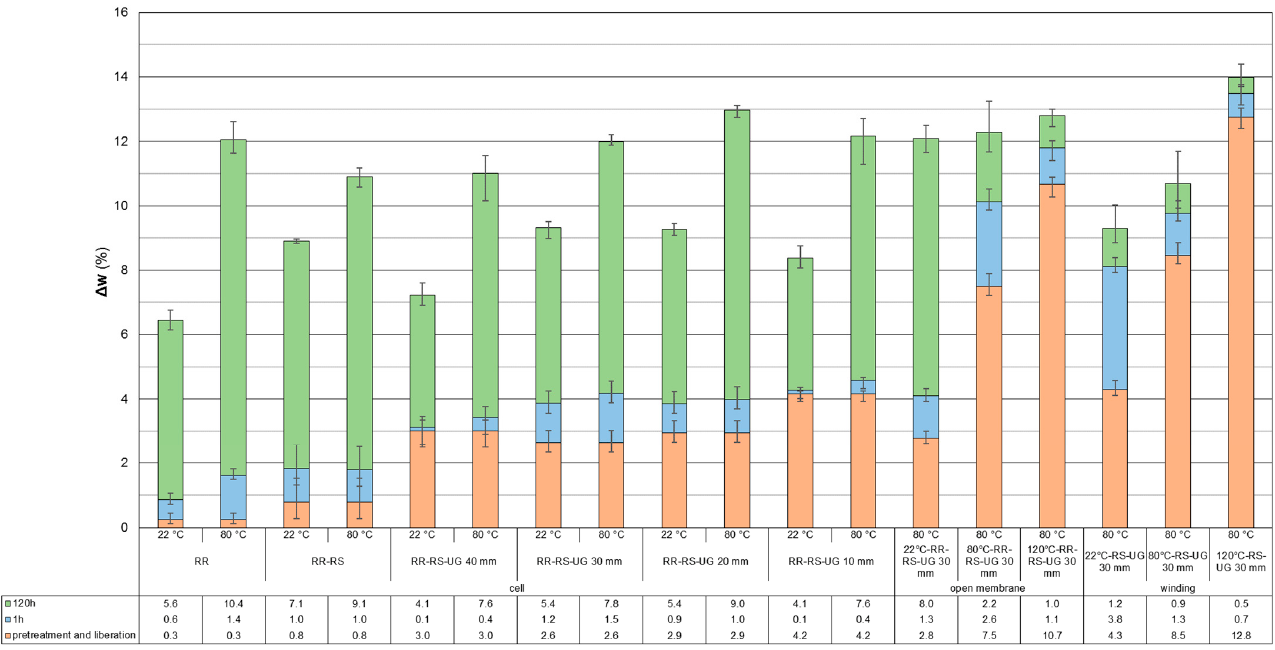
Figure 7. Influence of drying temperature and time on release of solvents due to thermal drying for different dismantling depths and crushing products (error bars indicate minimum and maximum).